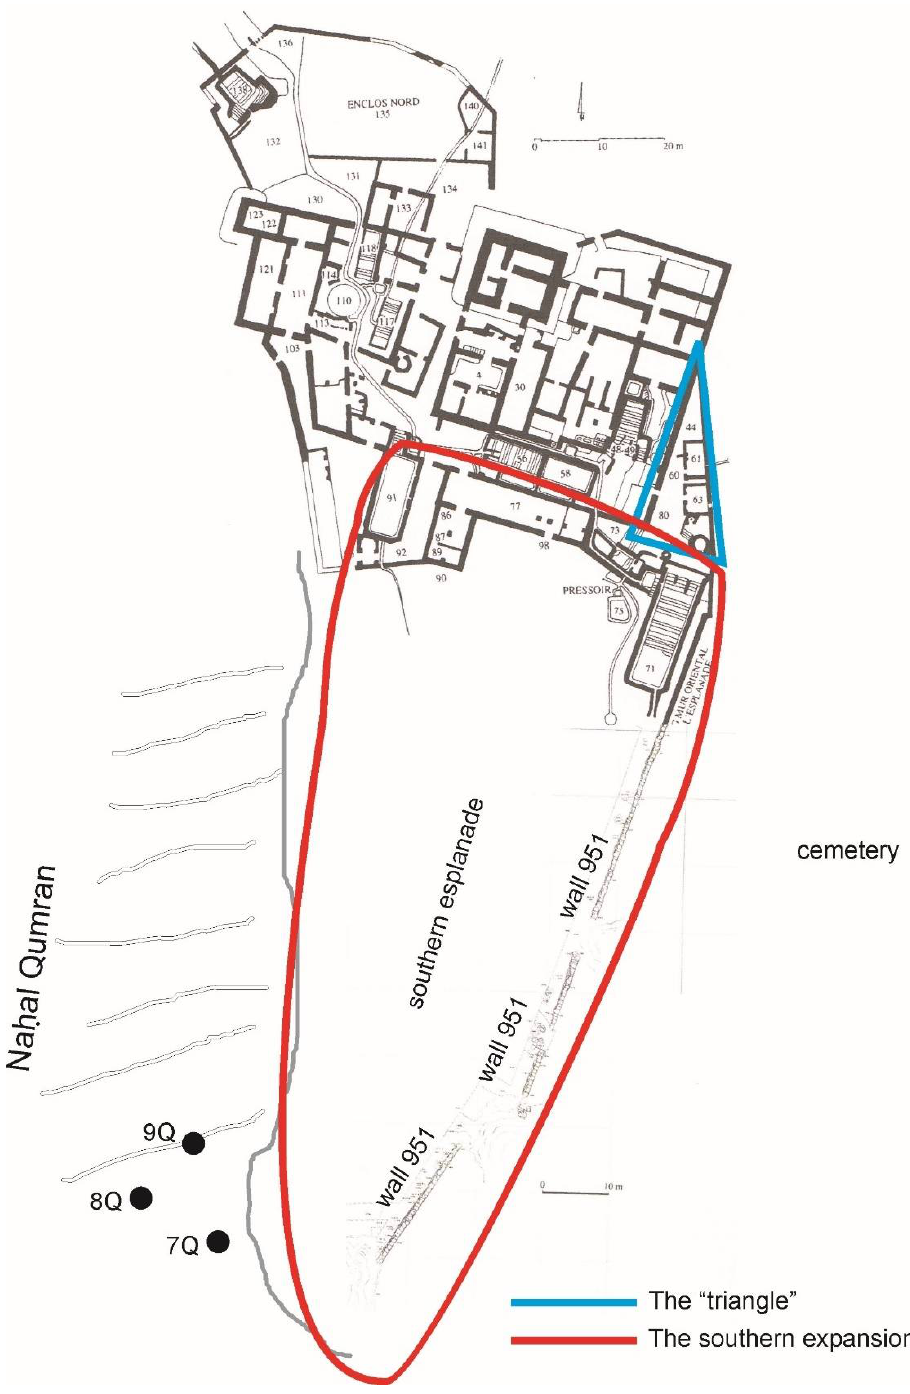
Figure 1. Based on Humbert 1994, p. 204 and Humbert and Chambon 2016.